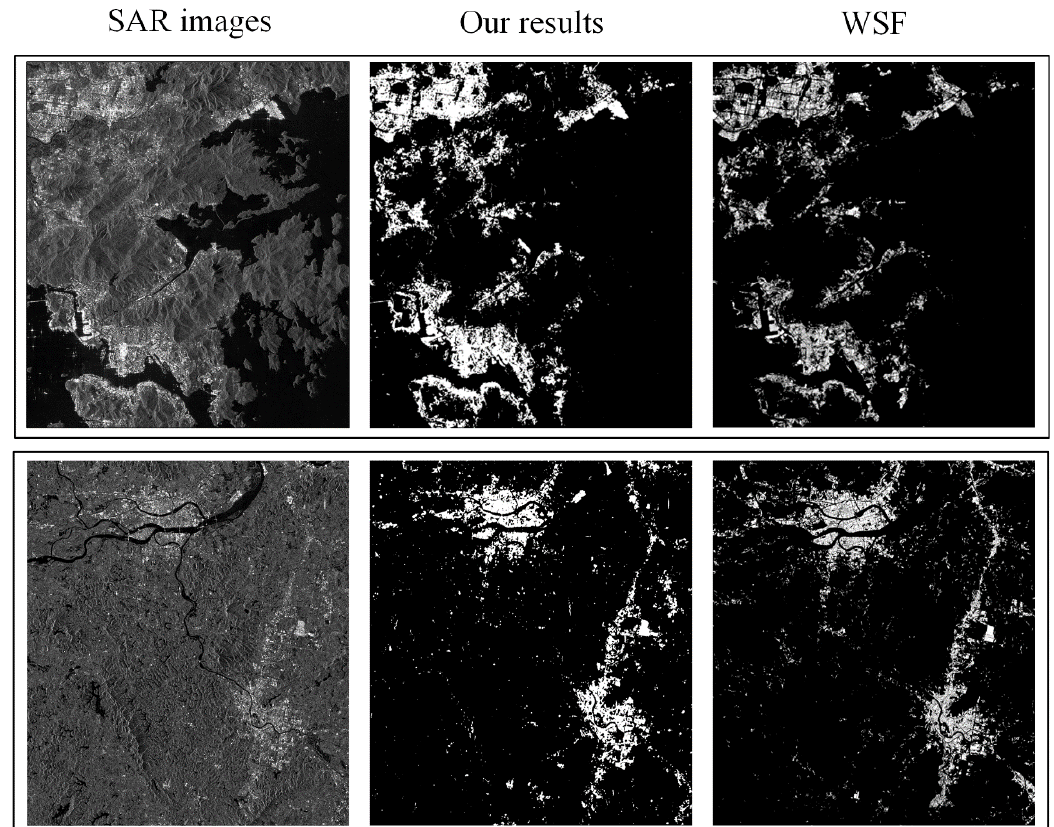
Figure 11. BAs extraction results of our method and the WSF for different regions. The first row denotes the results of Shenzhen and Hong Kong regions with an image size 3405 × 3869. The second row denotes the results of Taishan City and Kaiping City (regions of Jiangmen City) with an image size 2535 × 2754. The middle column is the results of our method, and the right column denotes the results of WSF product.